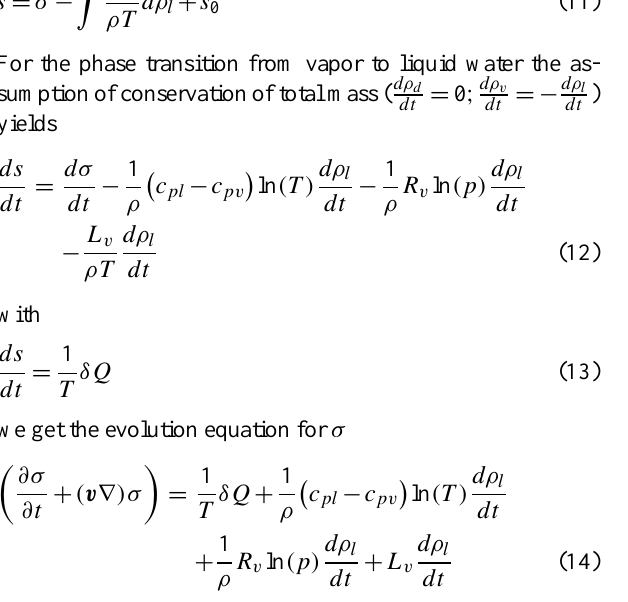
Fig. 1. Butcher tableau of the used Runge Kutta